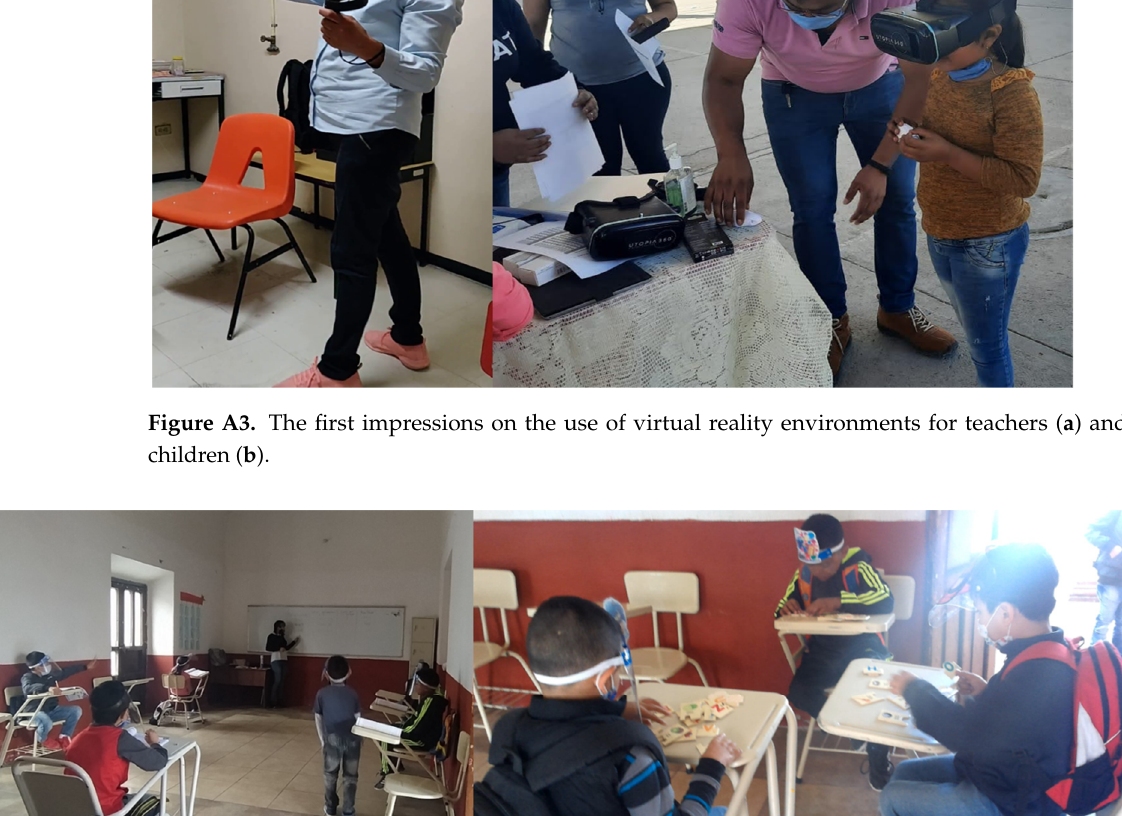
Figure A4. Teachers applying safety protocols such as the use of masks and disinfectant materials.